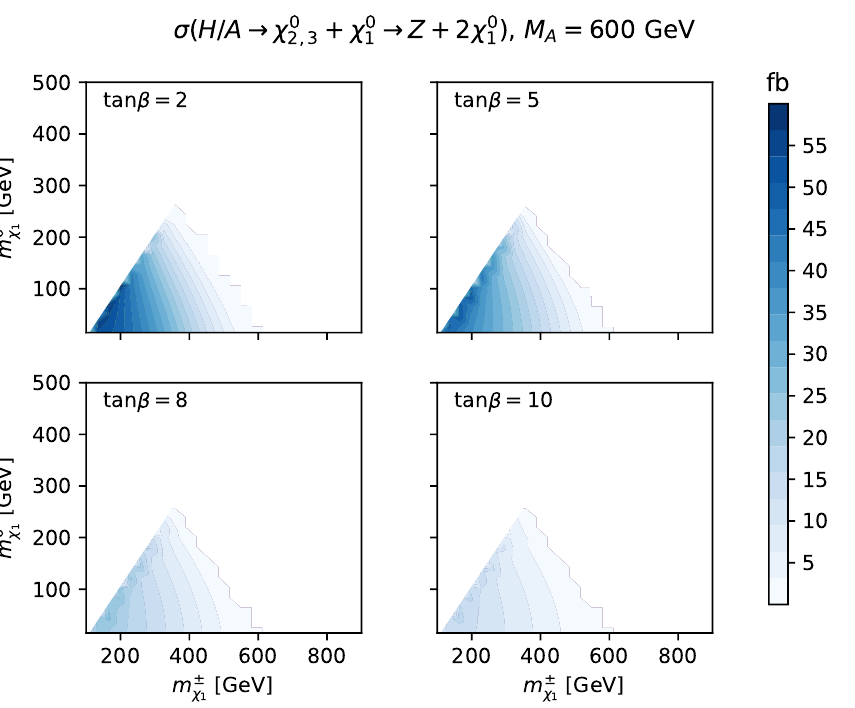
Figure 4 . The production cross-section for the process H=A electroweakinos, with heavy scalar mass m A = 600 GeV and tan (cid:12) = 2 ; 5 ; 8 ; 10